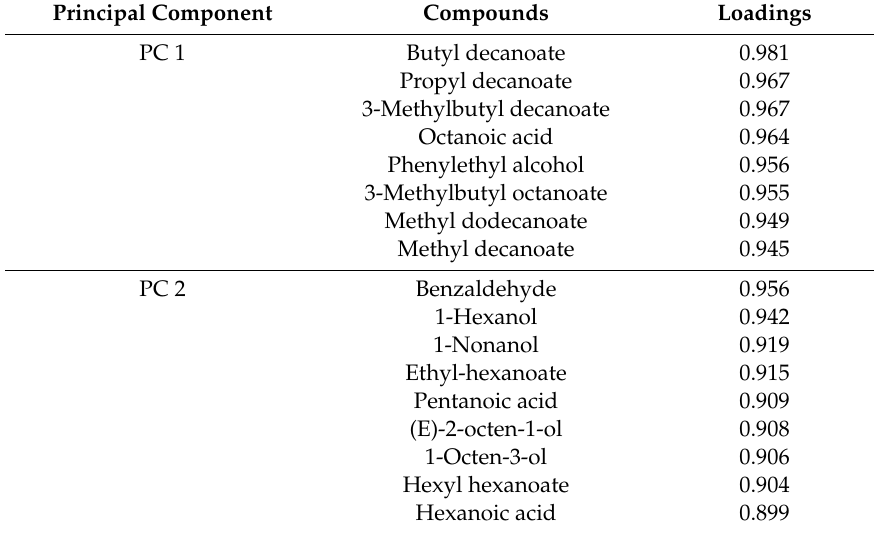
Table 5. Result of principal component analysis applied to volatile data obtained from deer burgers at 0 and 12 days of chilled storage. Volatile compounds more correlated with the two first Principal Component and their